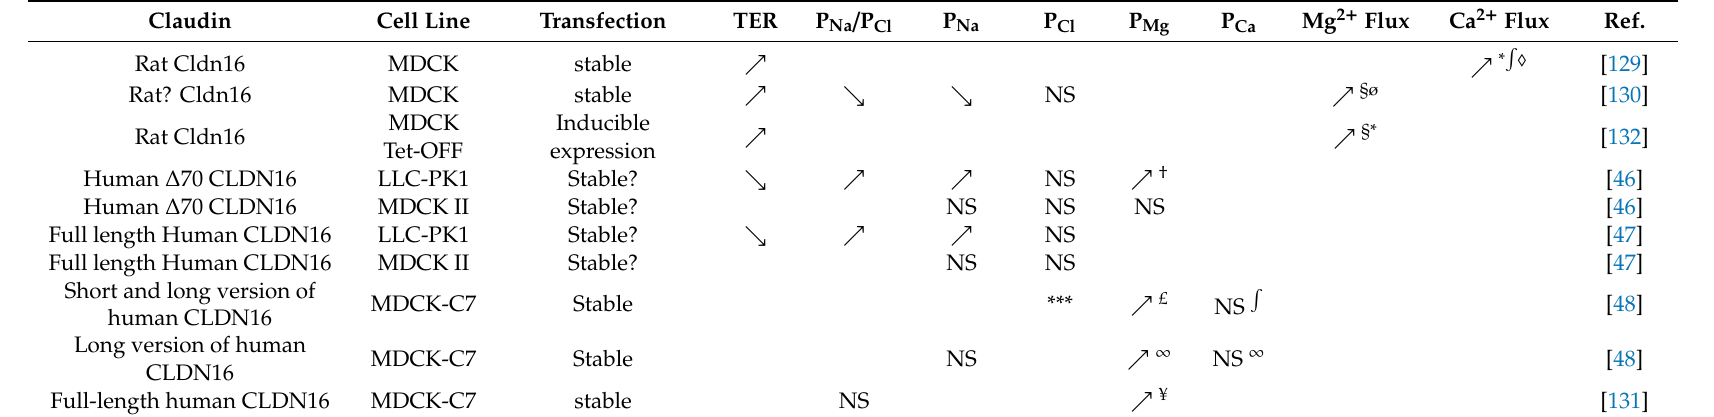
Table 6. Function of claudin 16 according to heterologous expression studies in cell